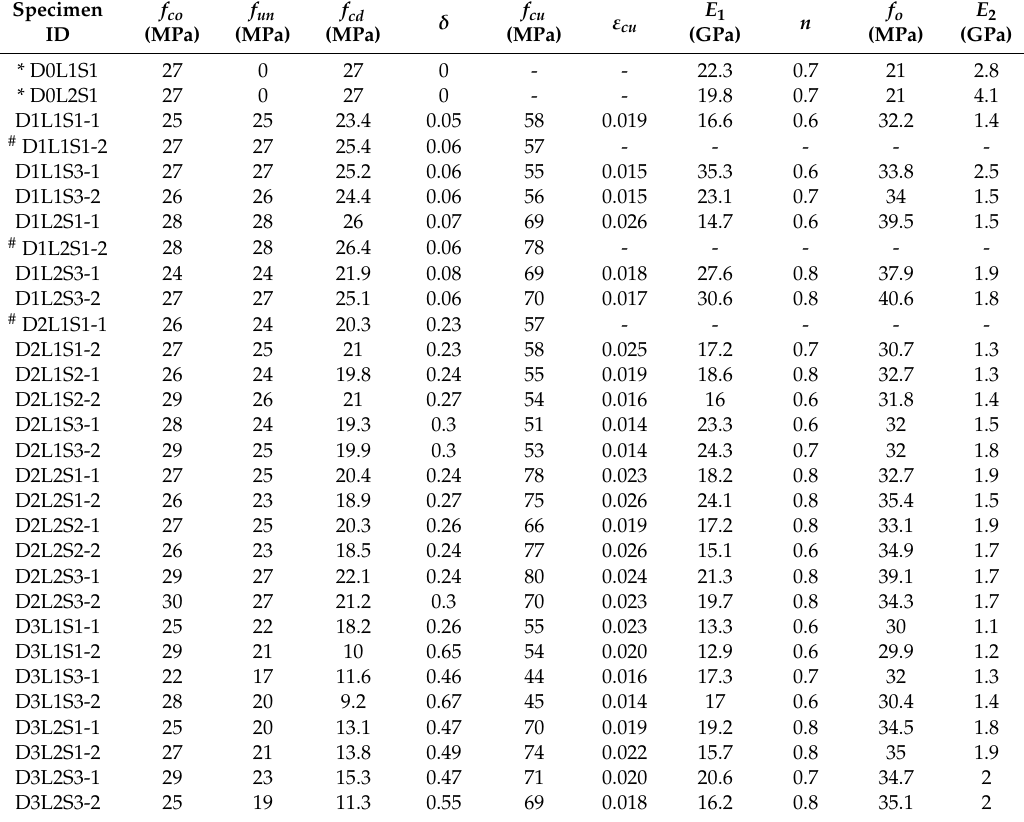
Table 1. Details of test